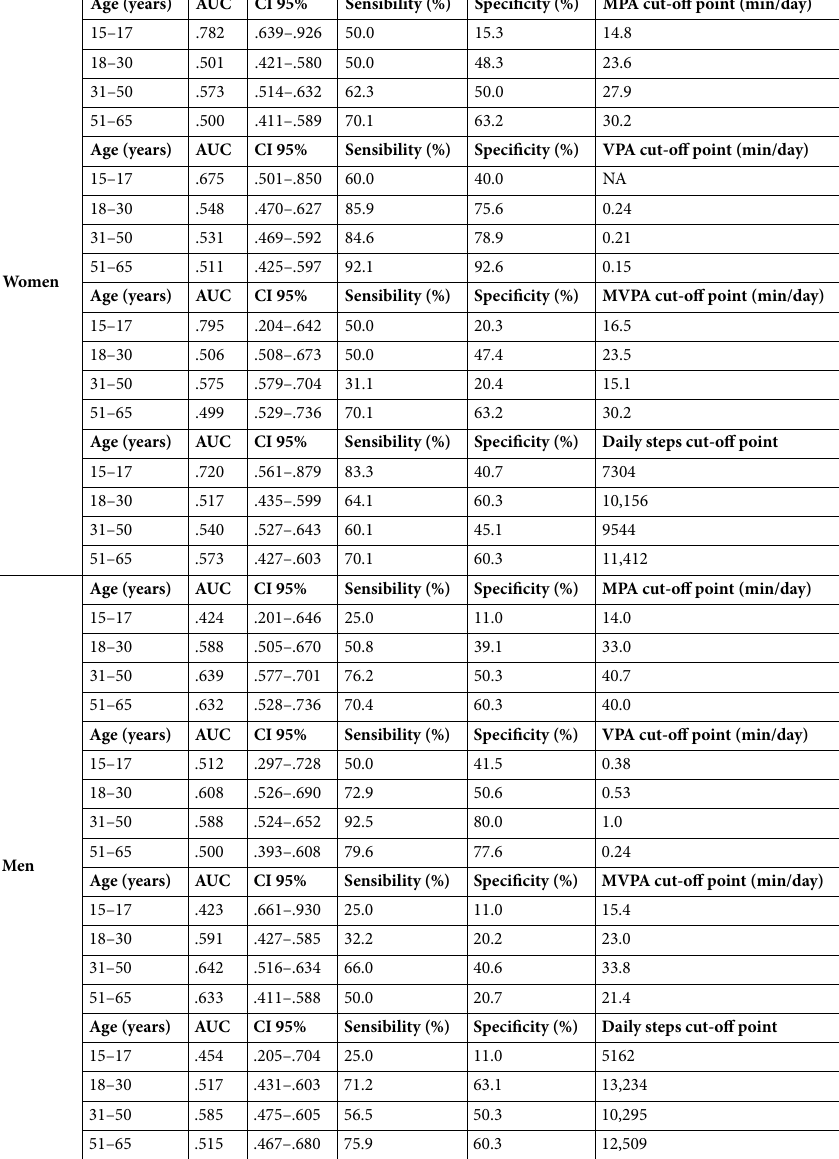
Table 3. Physical activity cut-off points (min/day) and number of steps according to sex and age categories in relation to BMI. AUC, area under the curve; CI 95%, confidence interval, MPA, moderate physical activity, VPA, vigorous physical activity, MVPA, moderate vigorous physical